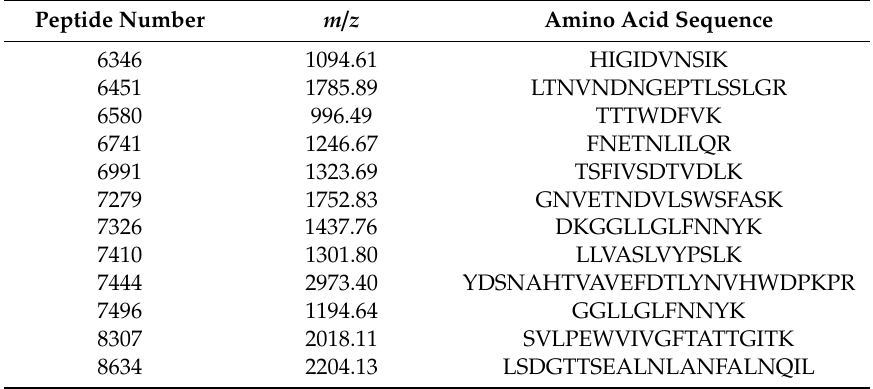
Table 4. The peptide of the lectin in an unknown sample as determined by Nano LC-ESI-MS /